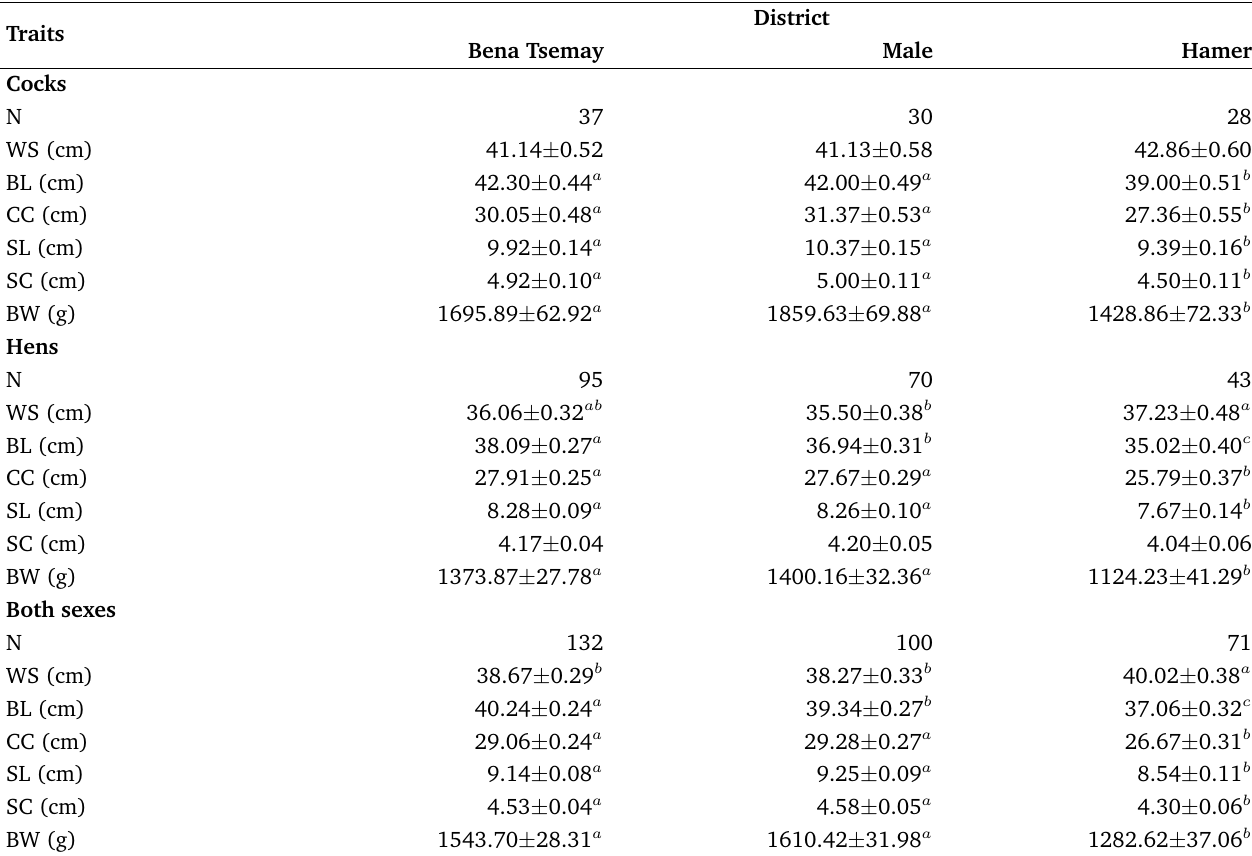
Table 4. Pairwise mean comparison (least square means and standard errors (LSM ± SE)) for the effect of district within each sex. Means within a column bearing different superscripts are significantly different; a is given to the highest value. N = number of observations, WS = Wingspan, BL = Body length, CC = Chest circumference, SL = Shank length, SC = Shank circumference, BW = Body